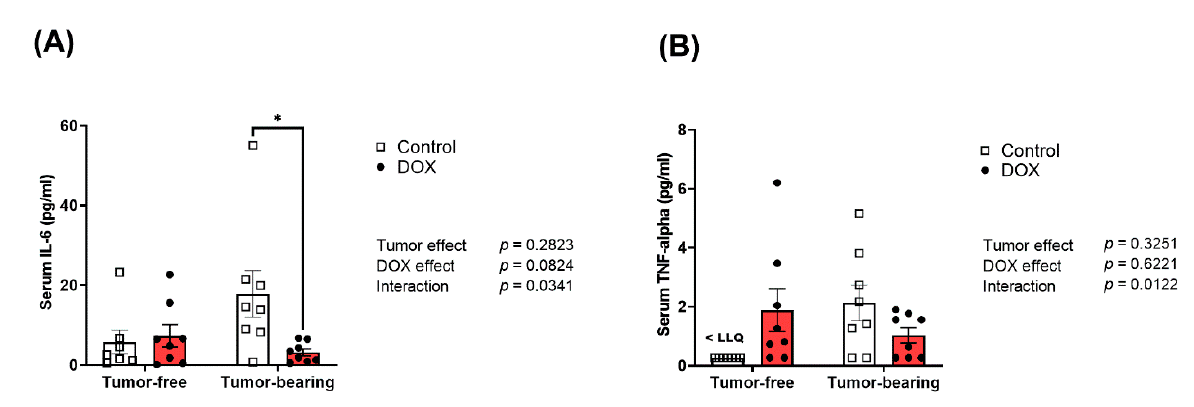
Figure 6. Histopathological evaluation of tumor-free and EL4 lymphoma tumor-bearing juvenile C57BL/6N mice euthanized one week following the administration of 4 mg/kg/week of DOX or equivalent volume of sterile saline for 3 weeks. Representative images from hematoxylin and eosin (HE)-stained sections of ( A ) heart, ( B ) liver, and ( C ) kidney are shown. Scale bar = 50 µ M (A and B) and 100 µ M (C).